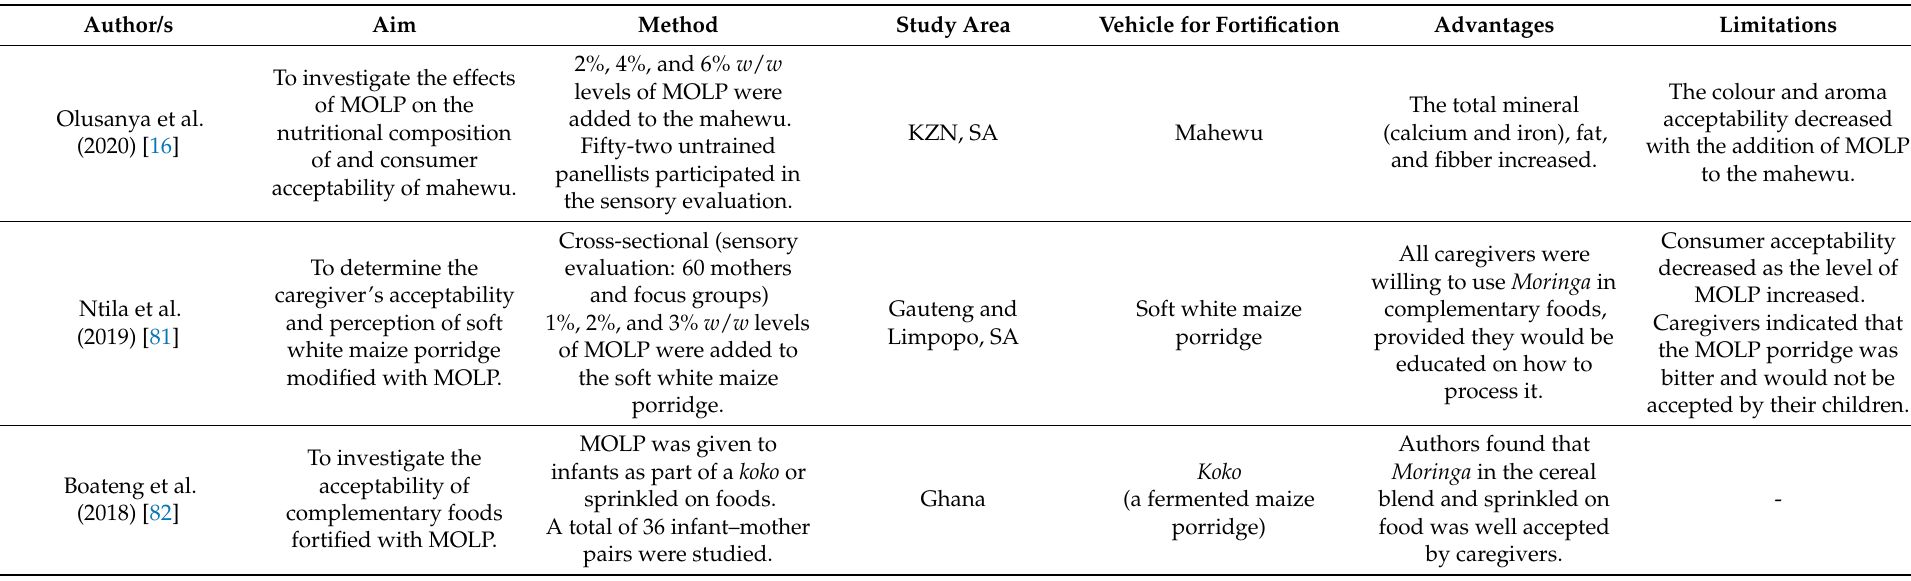
Table 2. The advantages and limitations of using MOLP as a fortificant in foods that can be used for complementary